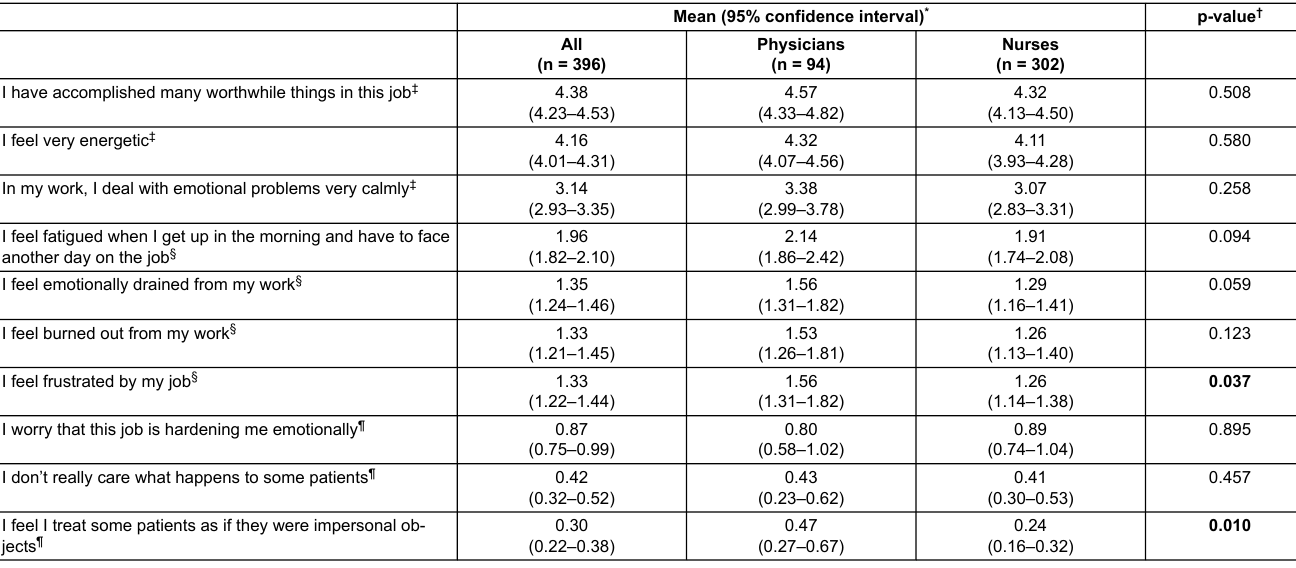
Table 1: Selected questions from the Maslach Burnout Inventory: by